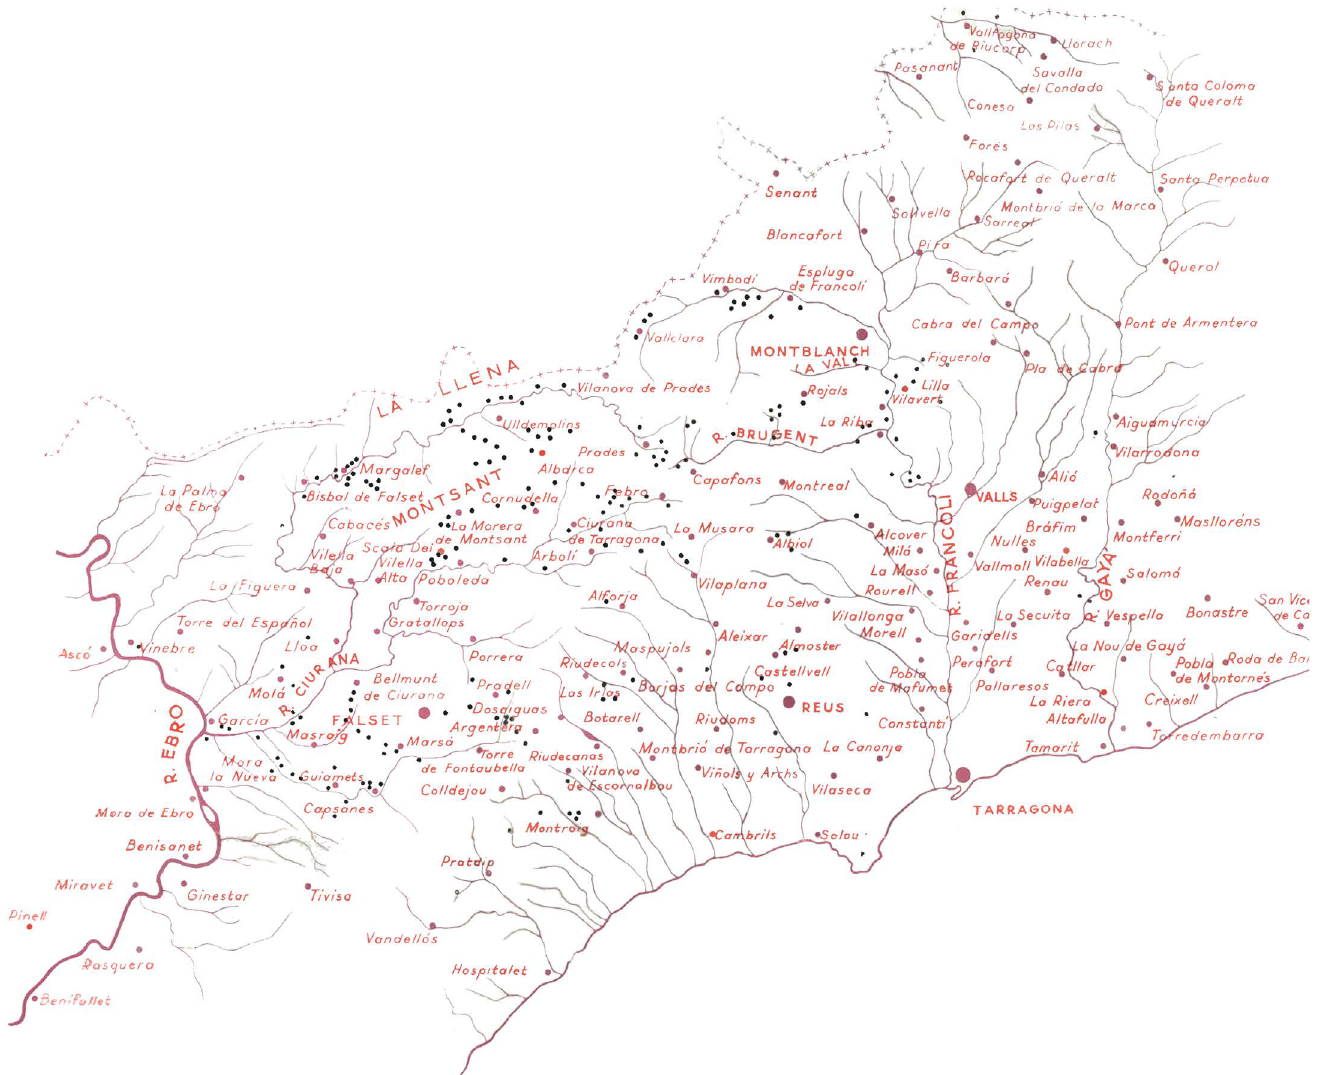
Figure 2. Map of the chert outcrops and archaeological sites (black dots) located in the area during the first half of the 20 th century (Vilaseca 1953: